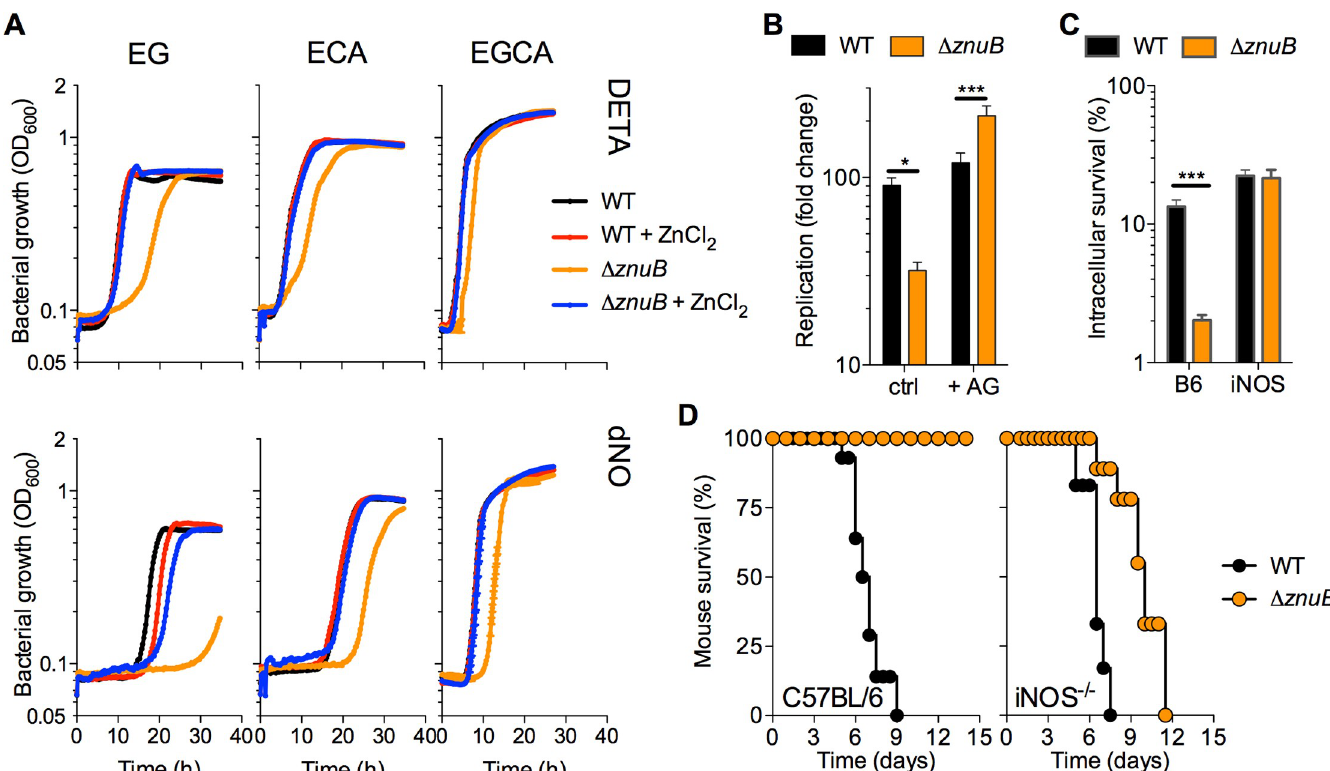
Fig 3. Salmonella require znuB to recover from nitrosative stress and cause disease. (A) Growth of wild-type (WT) and Δ znuB Salmonella after challenge with 5 mM diethylenetriamine (DETA) or 5 mM DETA NONOate (dNO) in E salts minimal media supplemented with glucose (EG), casamino acids (ECA), or glucose and casaminmo acids (EGCA). Where indicated, media were supplemented with 5 μ M ZnCl 2 (+ZnCl 2 ) (N = 5 to 10, mean). (B) Intracellular growth of WT and Δ znuB Salmonella after 20 h of culture in J774 macrophage-like cells. Select samples were treated with 500 μ M of the iNOS inhibitor aminoguanidine (AG) (N = 16, mean ± S. E.M.). (C) Intracellular survival of Salmonella in periodate-elicited macrophages from C57BL/6 or iNOS -/- mice (N = 5, mean ± S.D.) � and ��� , p < 0.05 and < 0.001, respectively, as determined by two-way ANOVA. (D) Survival of C57BL/6 or iNOS deficient (iNOS -/- ) mice infected i . p . with approximately 100 CFU of wild-type (WT) or Δ znuB Salmonella (N = 7–9 mice). p < 0.0001 and 0.001 for C57BL/6 and iNOS -/- , respectively, as determined by logrank analysis.